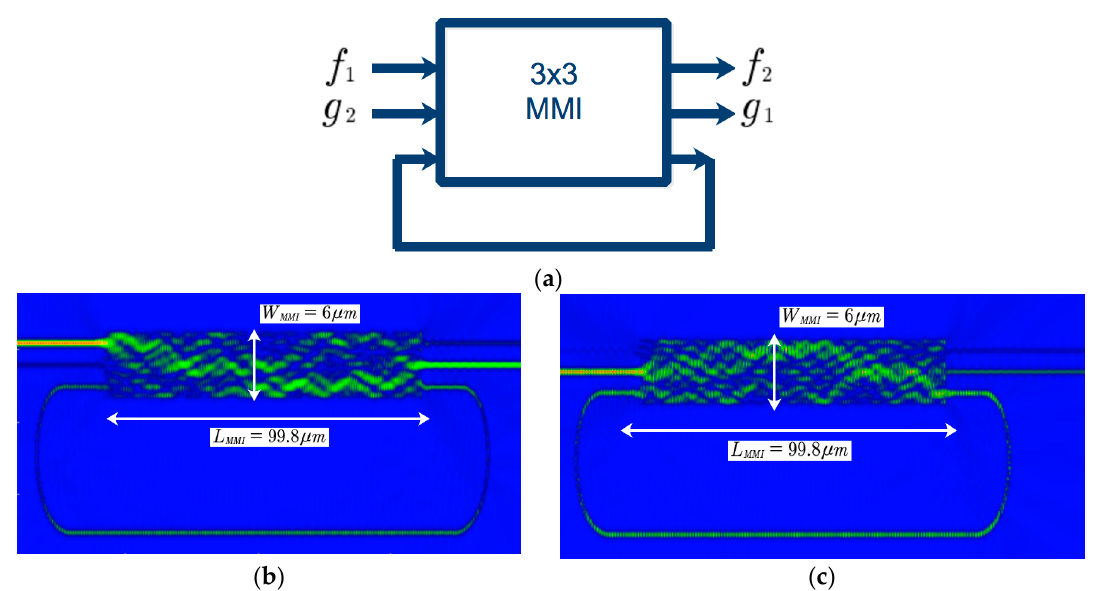
Figure 1. ( a ) Fano resonance unit created by 3 × 3 MMI (multimode interference) based resonator ( b ) FDTD simulation for input 1 and ( c ) finite difference time difference (FDTD) simulation for input 2.